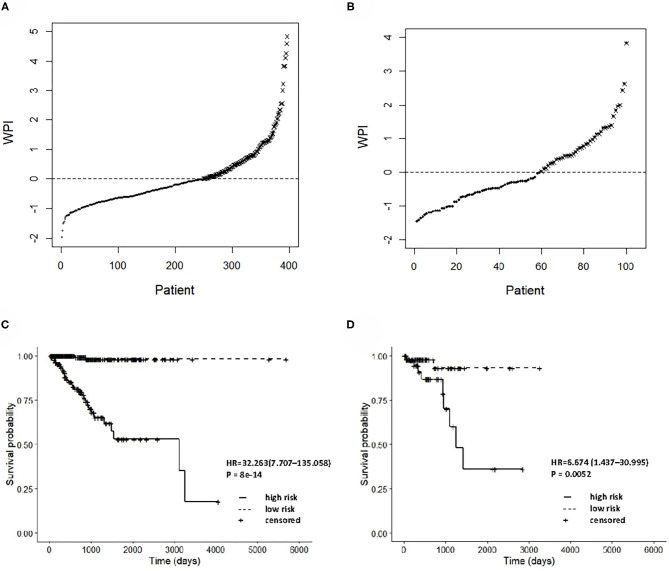
Prognostic performance assessment of integrated clinical-RNA prognostic model. WPI distributions and stratifications of EC patients in training set (A) and validating set (B), respectively. Kaplan–Meier curves for stratifications in training set (C) and validating set (D), respectively. WPI, weighed prognostic index; HR, hazard ratio.